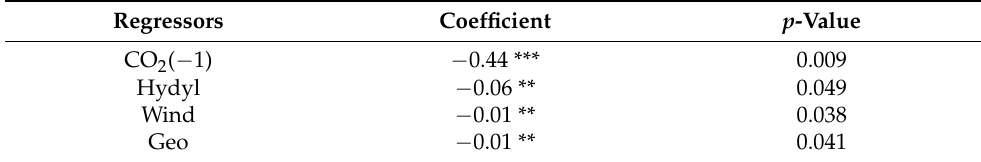
Table 8. L ong-run results